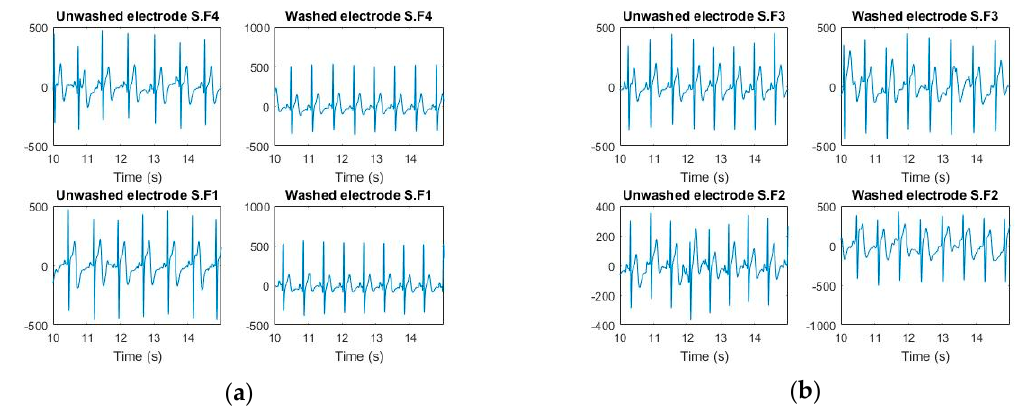
Figure 5. Power spectrum density (Silk wash), ( a ) F1 ( b ) F2 ( c ) F3 ( d ) F4.